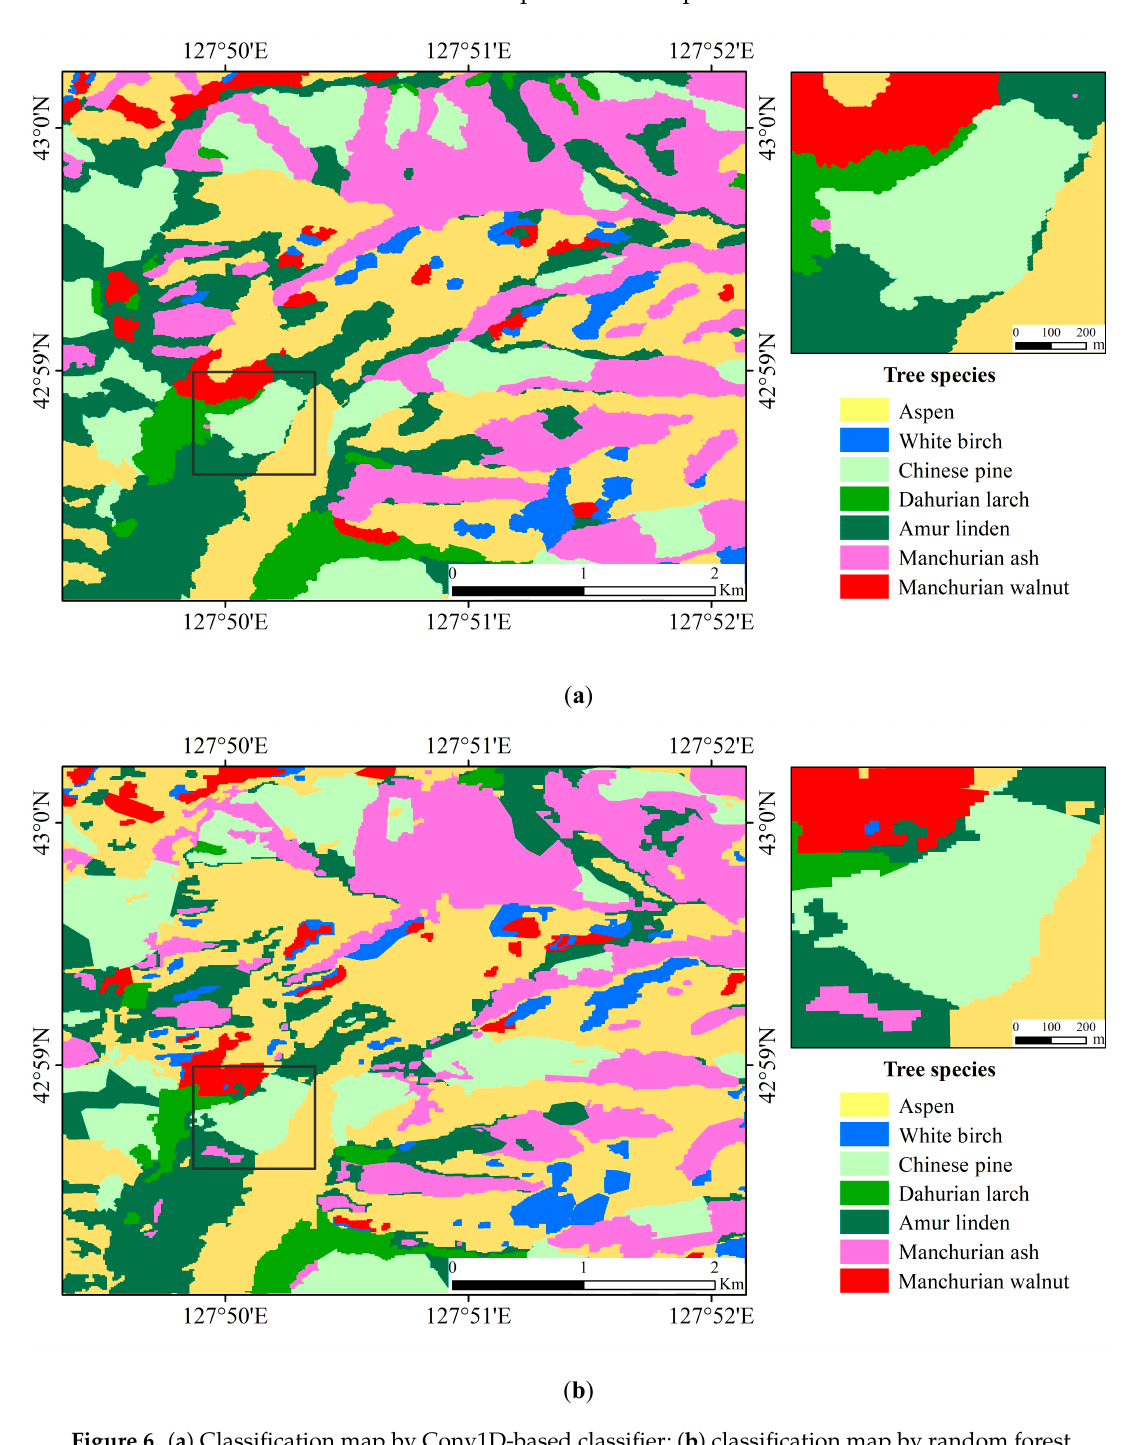
Figure 6. ( a ) Classification map by Conv1D-based classifier; ( b ) classification map by random forest (RF) classifier.